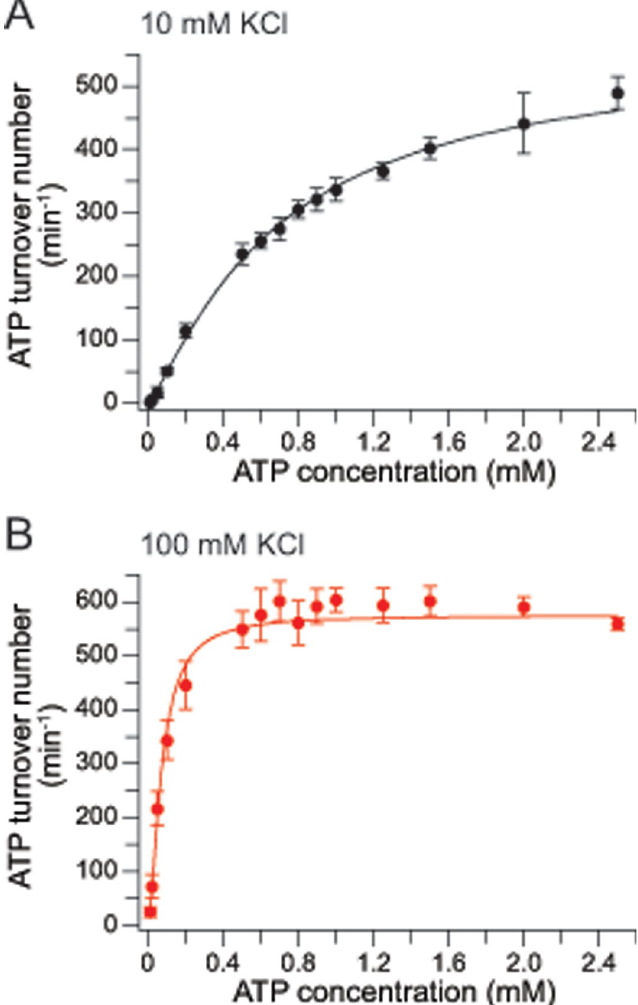
Fig 2. Concentration dependence of ATP hydrolysis by ɸ EL. (A, B) The curves show the concentration dependence of ATP hydrolysis by ɸ EL in presence of 10 (A) and 100 mM KCl (B). Shown are the averages of three experiments. Error bars indicate standard deviations. The red lines represent the Hill curve fittings of the